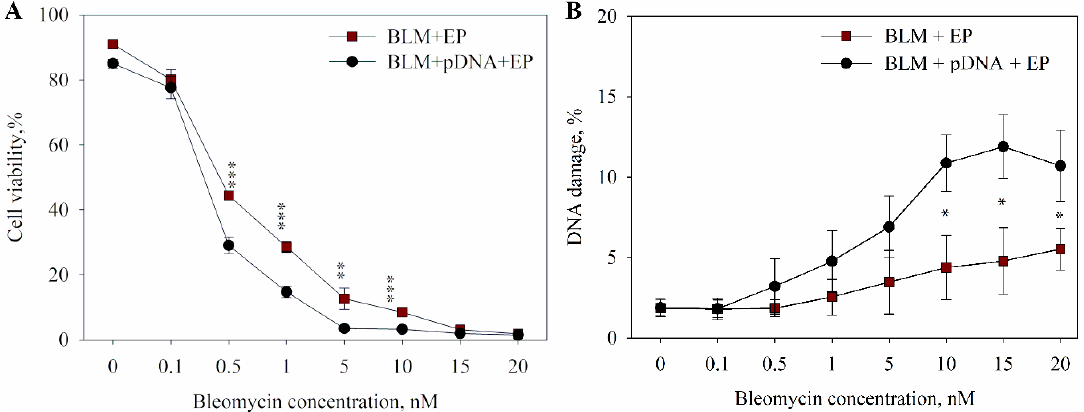
Figure 2. The dependence of cell viability ( A ) and DNA damage ( B ) on bleomycin (BLM) concentration and electroporation with or without extracellular plasmid DNA. The cells were electroporated with one high-voltage (1400 V/cm, 100 µs) electric pulse. The points on the curves at the 0 nM bleomycin concentration represent the control points (electroporation (EP) alone and EP with plasmid DNA). Two-tailed Student’s t -test p values < 0.05 between cells electroporated with or without extracellular plasmid DNA are marked with *, p < 0.01 is marked with **, and p < 0.001 is marked with ***. Comet categories are defined by the fluorescence intensity of the tail as well as tail